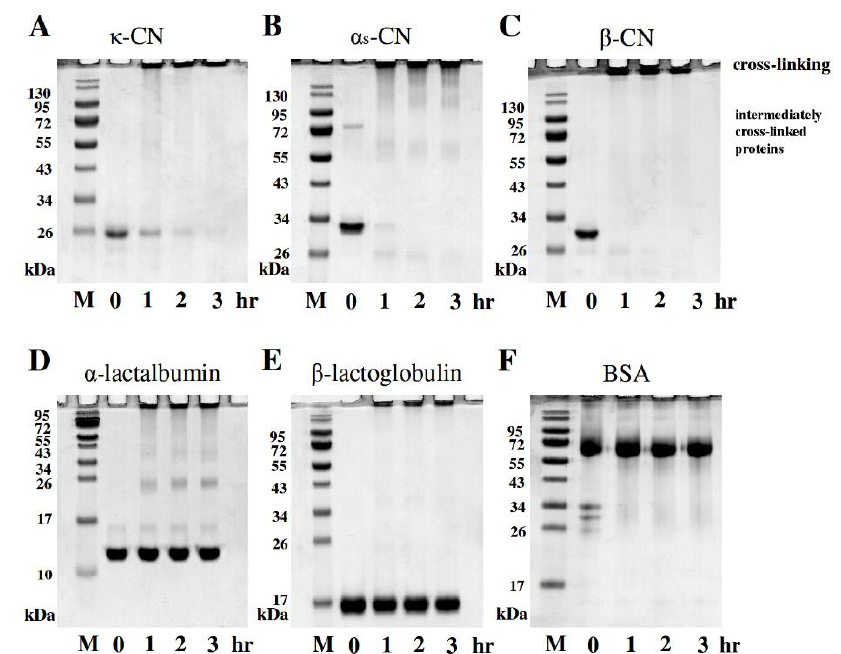
Figure 1. Changes in the SDS-PAGE profiles of milk proteins with 2.0 units/mL